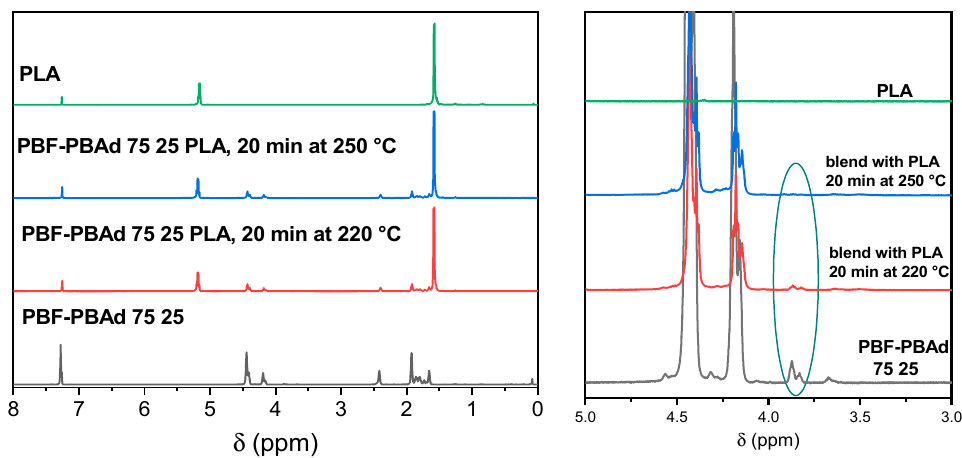
Figure 11. 1 H NMR spectra of the PBF-PBAd 75 25 PLA blends.